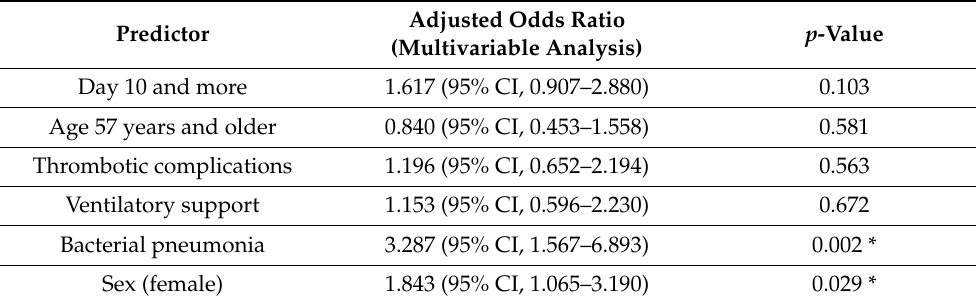
Table 8. Multivariable regression analysis: independent predictors of increased optical density (above 0.49) in venule endothelium (with adjusted odds ratio